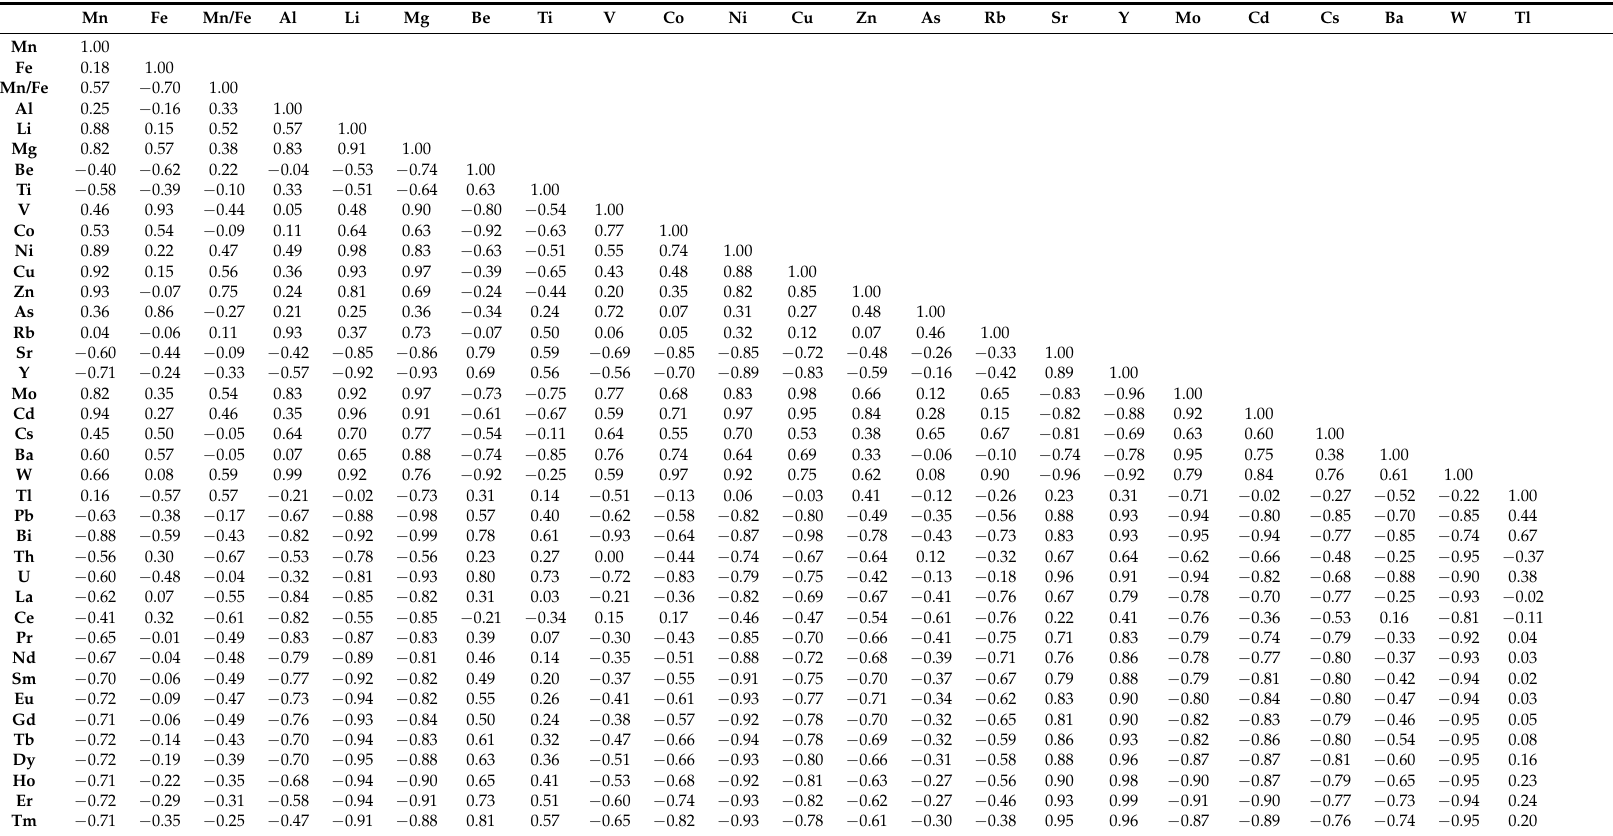
Table A1. Correlation coefficient matrix for nodule samples from the Brazil and Cape Basins (except Nod